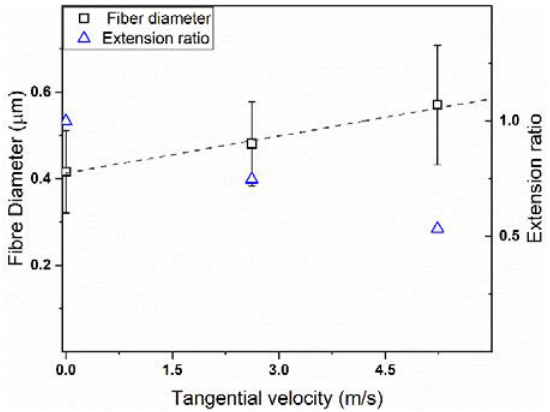
Figure 2. Fibre diameter (square symbols) and extension ratio (triangular symbols) dependence upon the collector velocity.